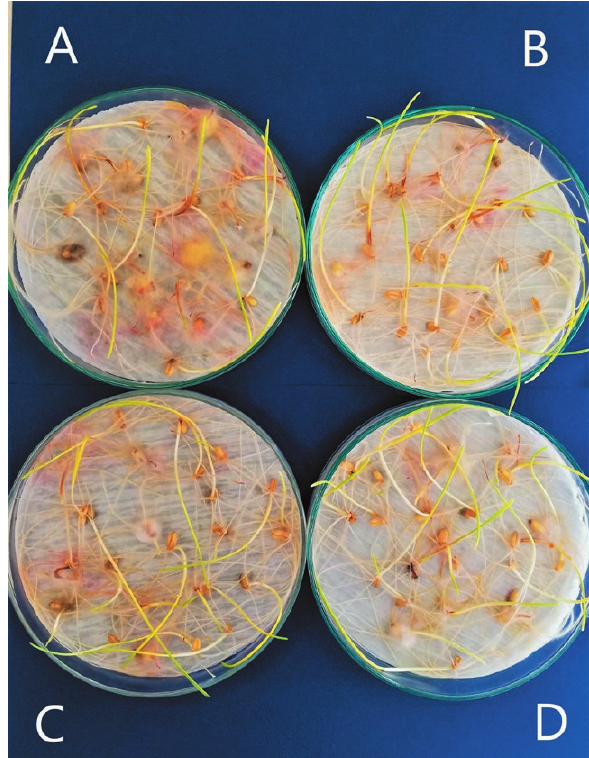
Figure 2. Wheat “Simeto” seedlings grown from seeds artificially inoculated with Fusarium culmorum and then treated with differ- ent bacterial endophyte strains. Suspensions of bacterial strains were applied at 1 × 10 6 CFU mL -1 on filter paper, onto which the seeds artificially inoculated with the pathogen were distributed. A, F . culmorum alone; B , F7 ( Pan . agglomerans ) + F . culmorum ; C, F15 ( Pan . agglomerans ) + F . culmorum ; D, A1 ( Pan . agglomerans ) + F . culmorum